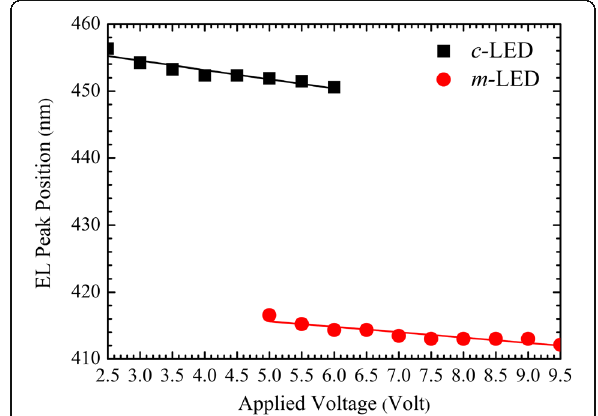
Fig. 2 EL peak position as a function of CW applied voltage for the c - and m -LEDs. EL peak positions are linearly fitted for comparisons